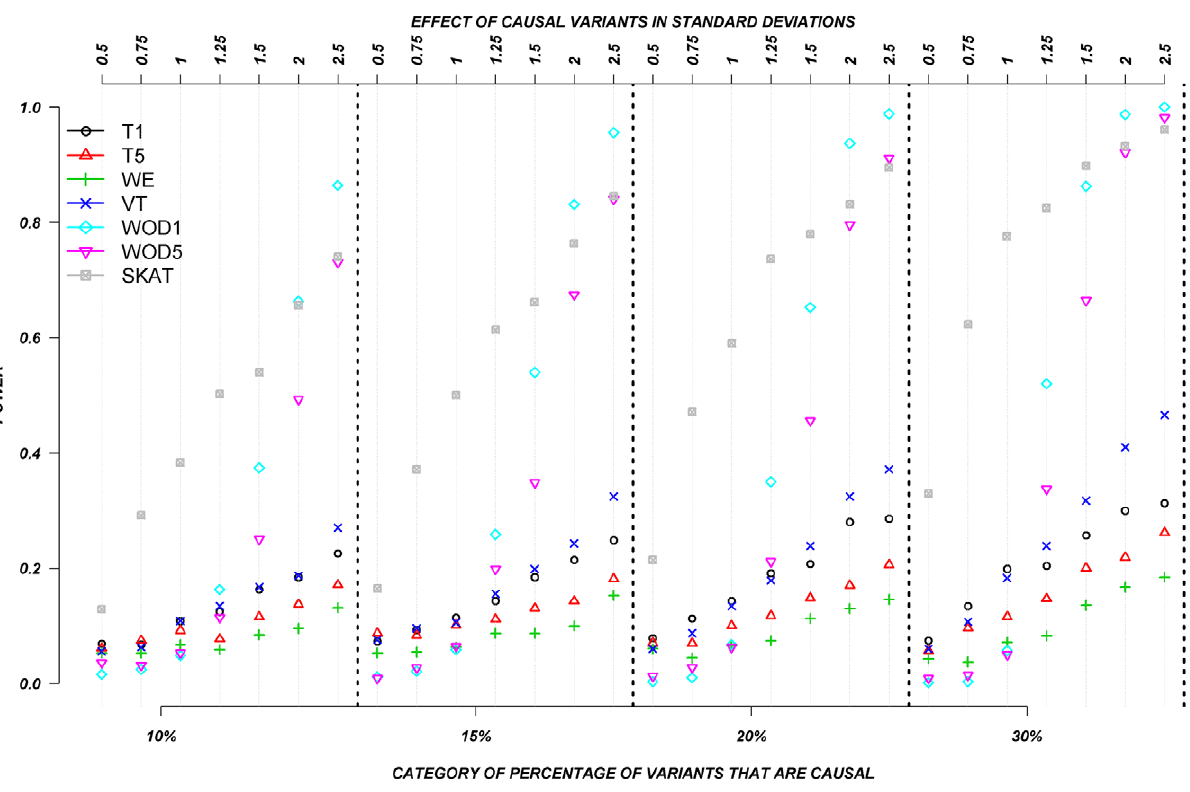
Figure 4. Continuous traits: Relationship between effect size, proportion of causal variants, and power, when causal variants are a mixture of protective and deleterious effects. Each box corresponds to a different proportion of causal variants involved in the relationship between rare variants and continuous traits (from left to right, 10, 15, 20 and 30%). On the x-axis, effect sizes are in standard deviations and correspond to the absolute value of the average size effect.